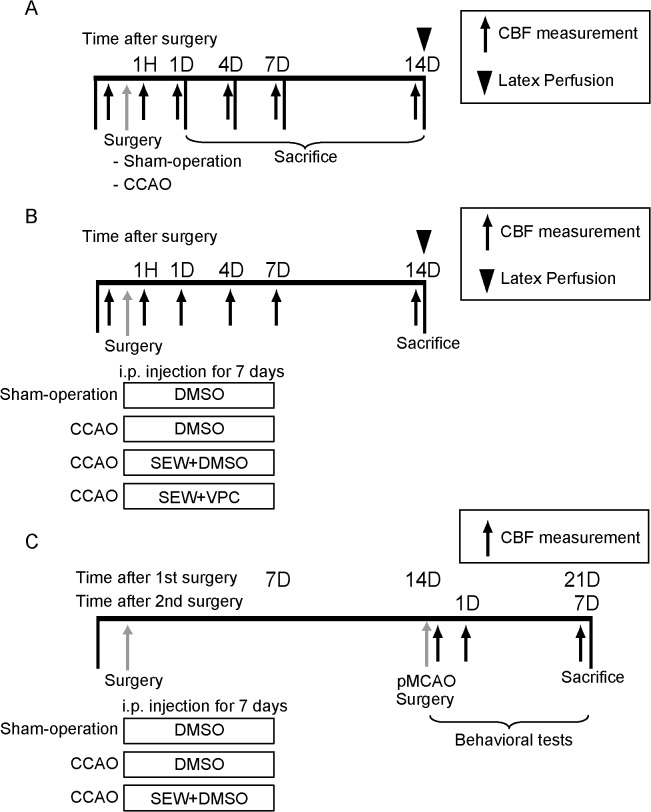
Ischemic surgery and treatment schedule.In the protocol I, animals were euthanized 1, 4, 7, or 14 days after surgery (A). In protocol II (B) and III (C). SEW, SEW+VPC, or control vehicle (DMSO) were administered intraperitoneally for 7 days after surgery.